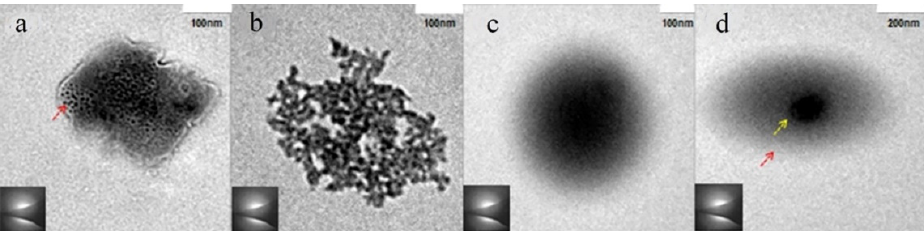
Figure 4. ( a – d ) show the TEM images of the evolution of the amorphous intermediate in the initial stage of L-glutamic acid phase separation. Red arrow in ( a ) indicates smaller units with a diameter of 3 nm to 5 nm in diameter. Yellow arrow in ( d ) indicates compaction process. The figure is reproduced with copyright permission of ref. [47].